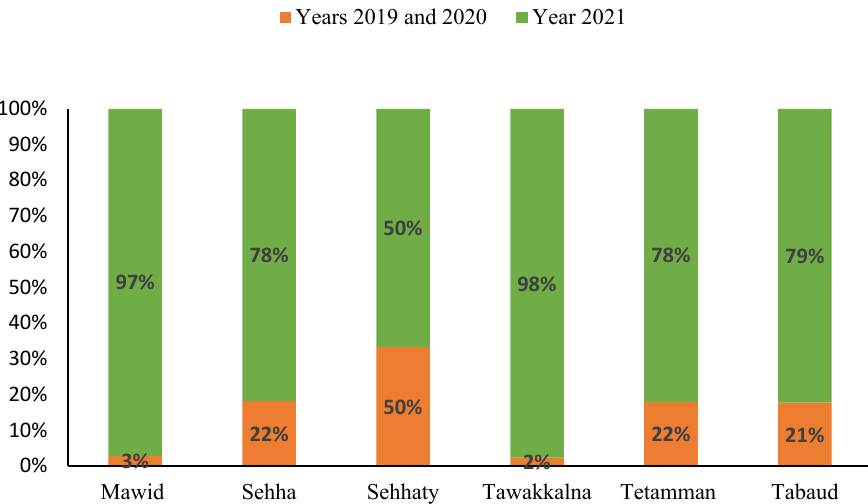
Figure 2. Increase in the number of registered users of DHTPs over the period from 2019 to 2021 [17,28]. Data presented as proportions